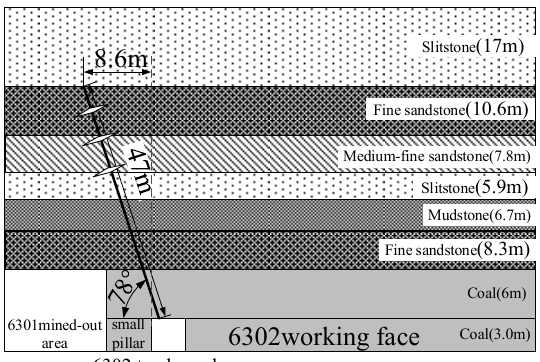
Figure 9. Construction position.